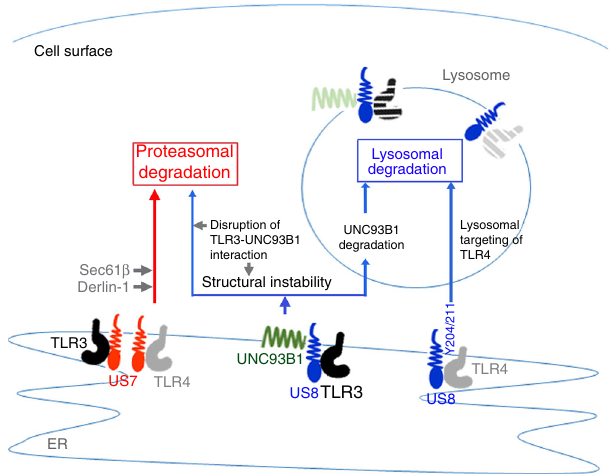
Fig. 7 Proposed model of the novel function of HCMV US7 and US8 in the inhibition of TLR3- or TLR4-mediated innate antiviral response. Schematic model of US7- or US8-mediated negative regulation of antiviral response by targeting TLR3 and